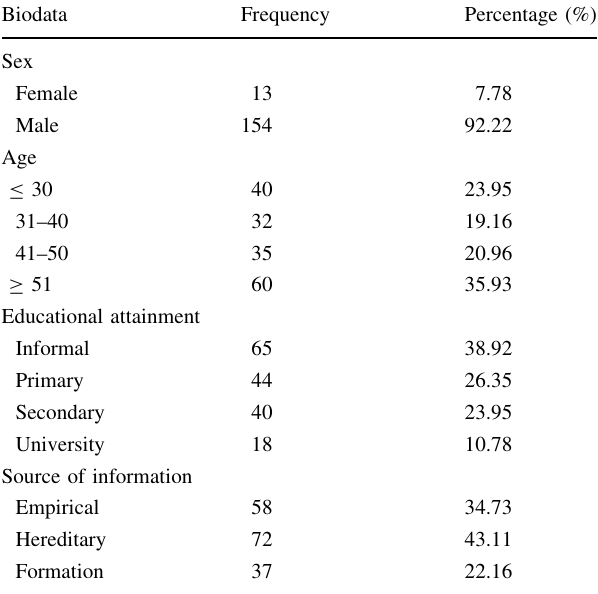
Table 2 Sociodemographic characteristics of the traditional herbalists